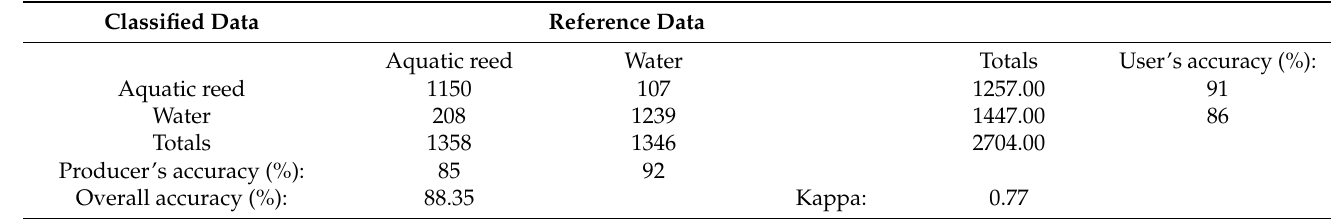
Table 2. Accuracy assessment showing the comparison between classified reed extent areas and reference data.